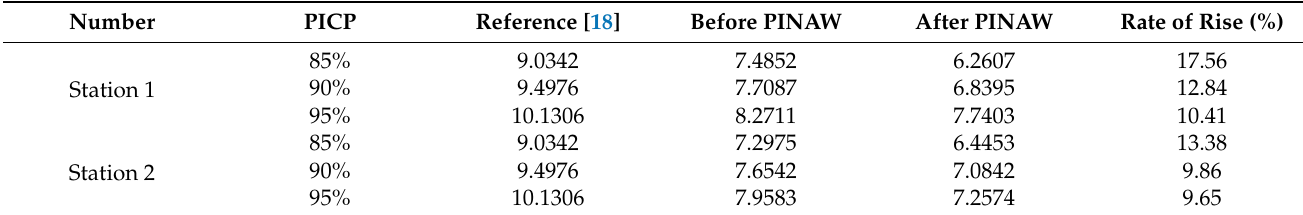
Table 3. Comparison before and after multi-objective